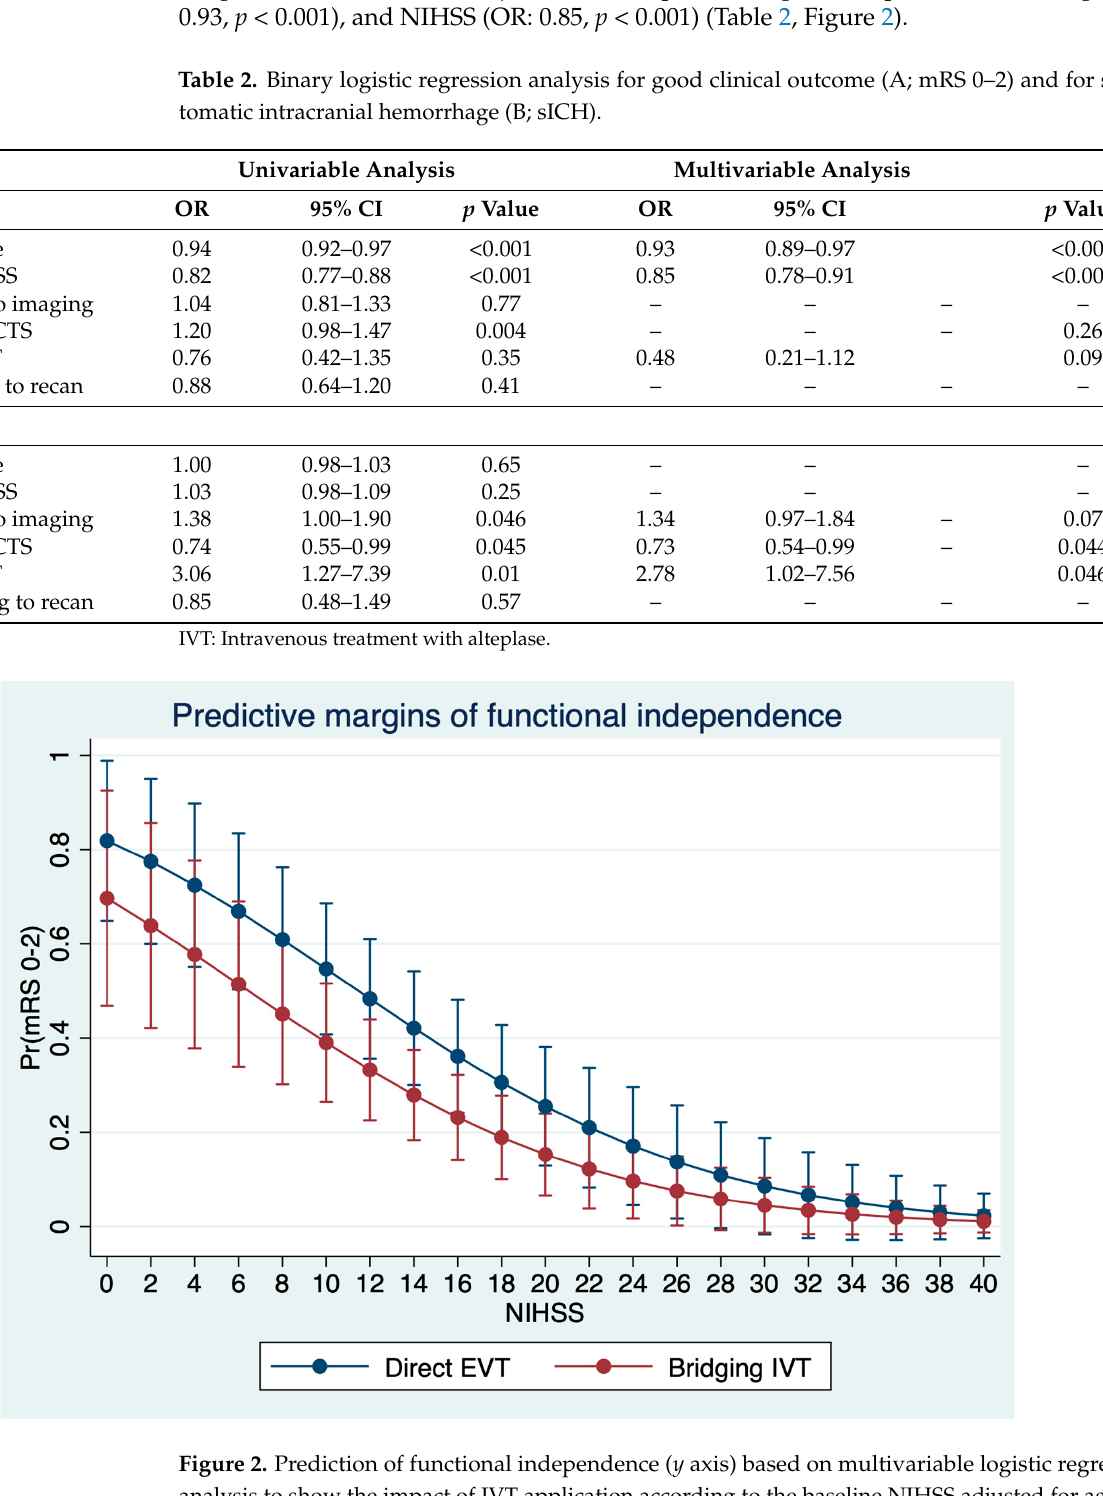
Table 2. Binary logistic regression analysis for good clinical outcome (A; mRS 0–2) and for sympto- matic intracranial hemorrhage (B; sICH) .